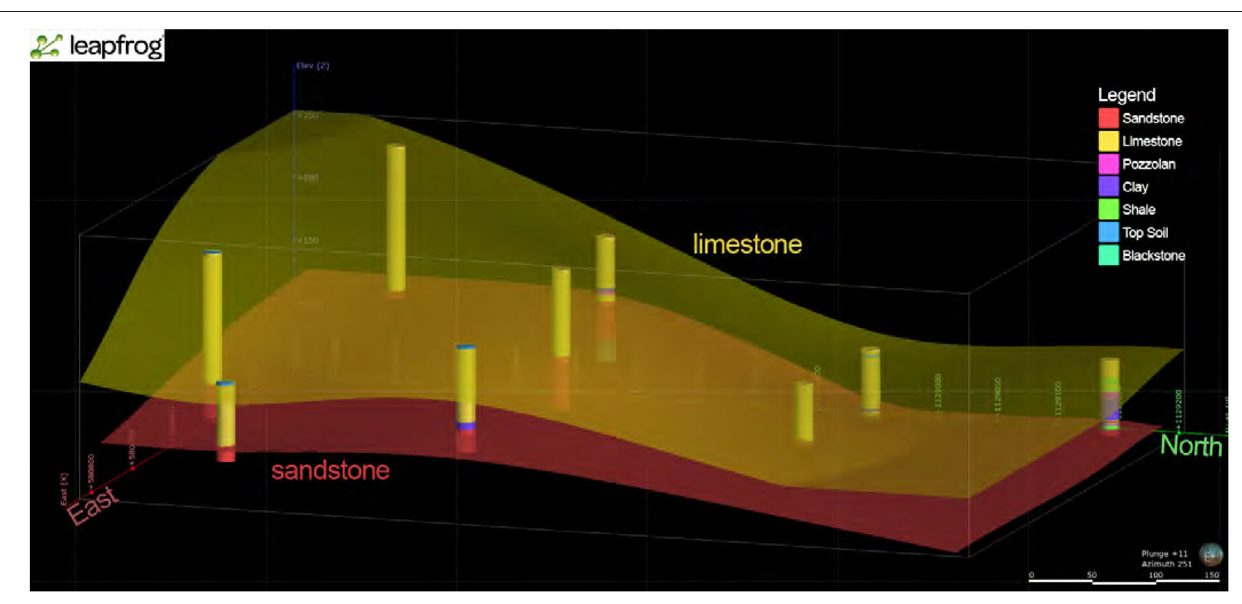
given the range of rock types with various ages they cut through. Of particular interest are the set of fractures that have a general northeast direction, which correspond to the northward projection of the strike of the Naga landslide head wall ( Figure 12